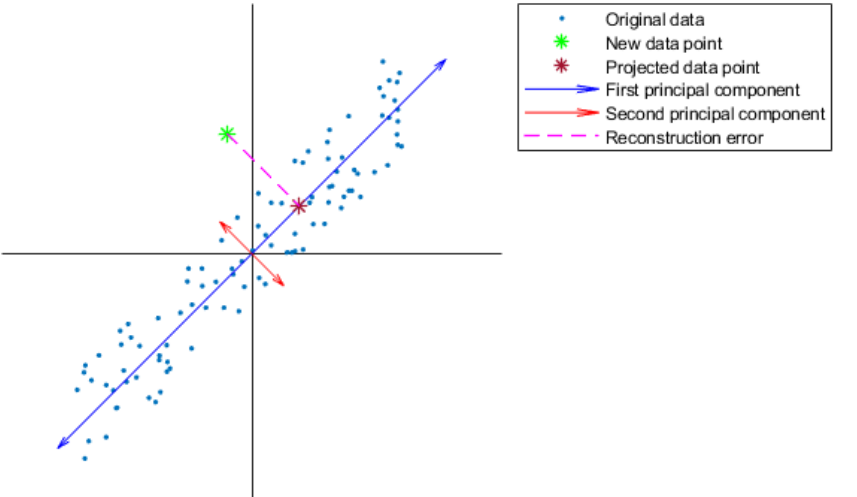
Figure 1. Illustration of PCA-data reconstruction [20]. A new data point (green star) is projected onto the first principal component (blue arrow), yielding the projected data point (dark crimson star). The difference between the new data point and the projected data point is the reconstruction error.